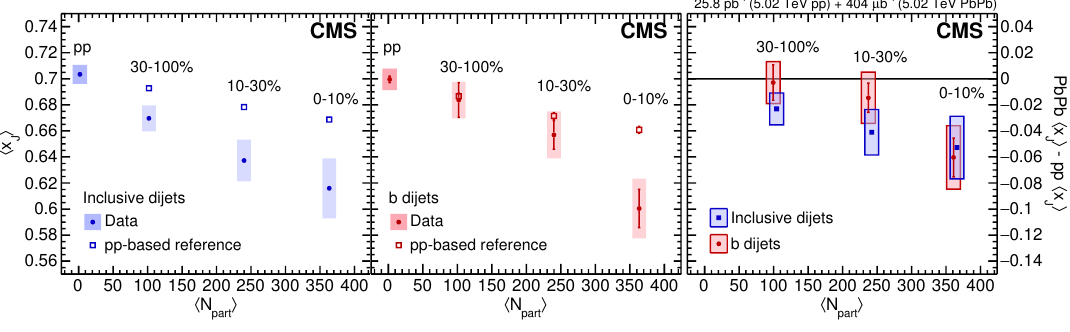
Figure 6 . h x J i for inclusive (left) dijets and b dijets (center) in pp collisions and for di(cid:11)erent centrality selections of PbPb collisions. The right panel shows the di(cid:11)erence in the h x J i values between PbPb and the smeared pp reference. Systematic uncertainties are shown as shaded boxes, while statistical uncertainties are shown as vertical